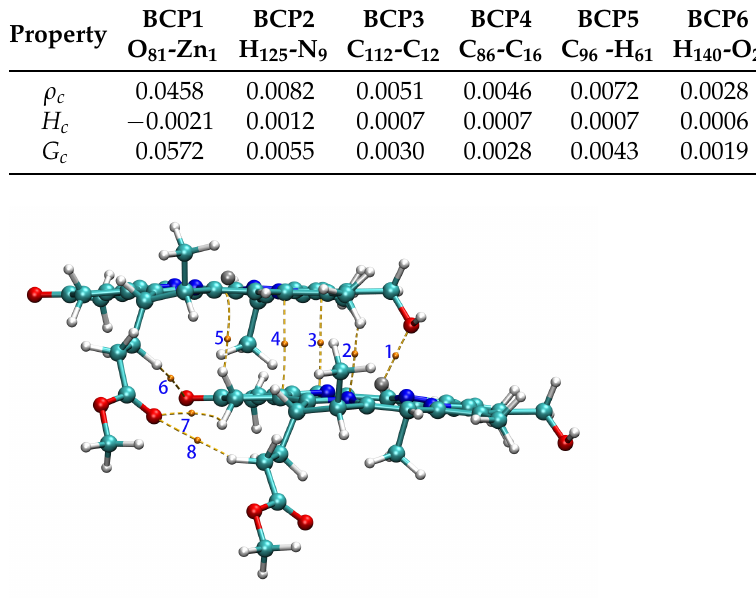
Figure 6. BCPs (in yellow) and paths between two Znchl monomers in the